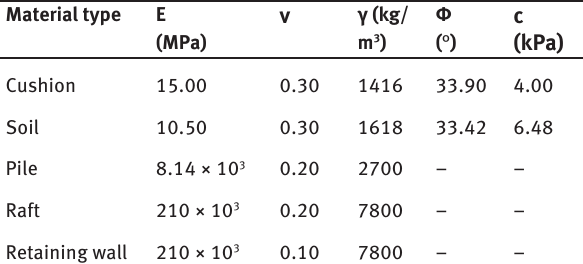
Table 1: Material properties used in